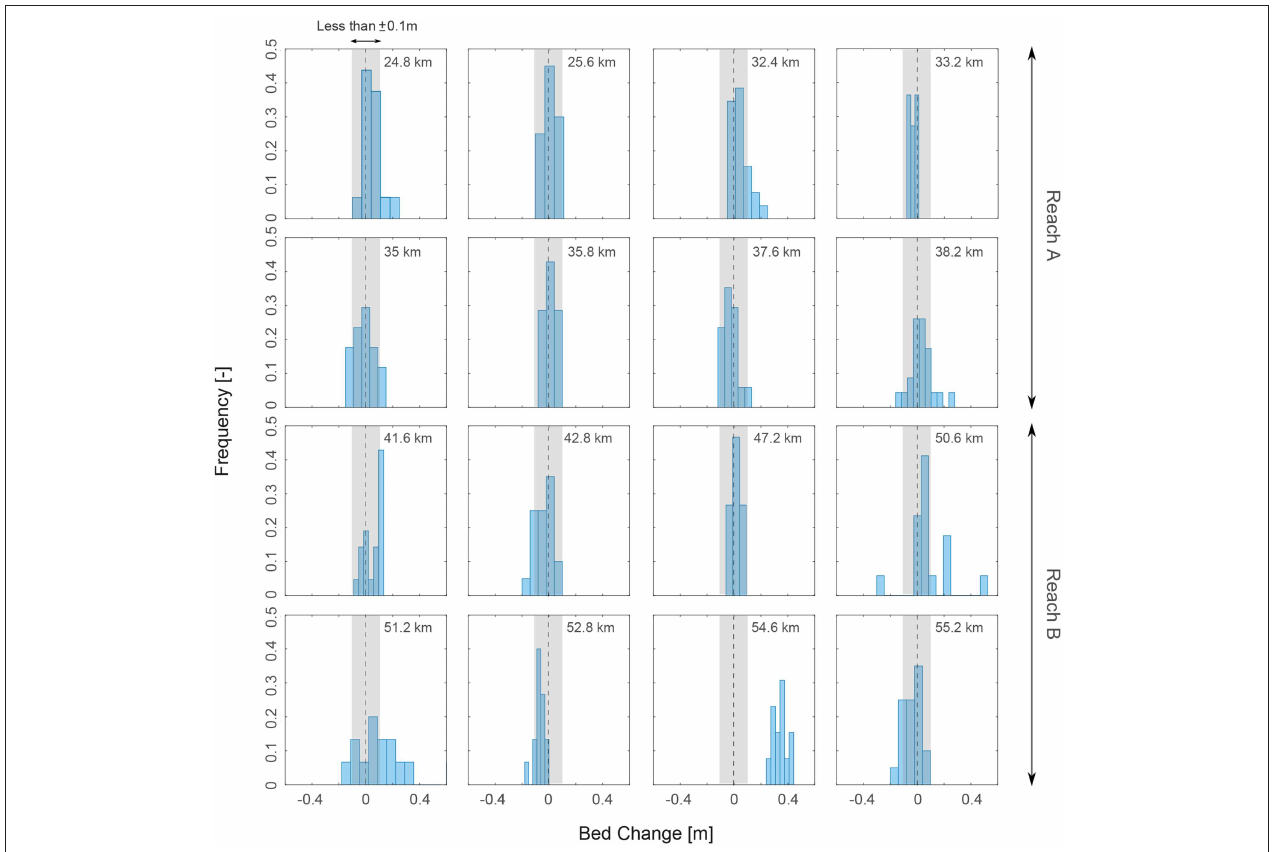
( Figure 12 ). The occurrence of the flood in August